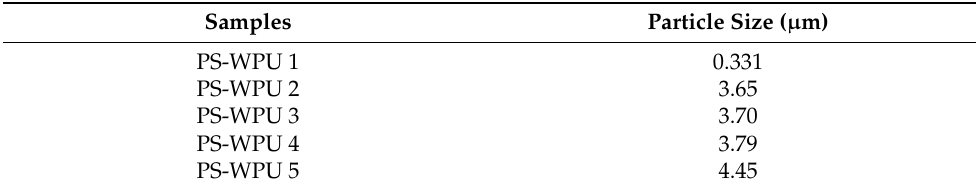
Figure 2. Particle size distribution of PS-WPU samples. Table 2. Particle size of PS-WPU samples.